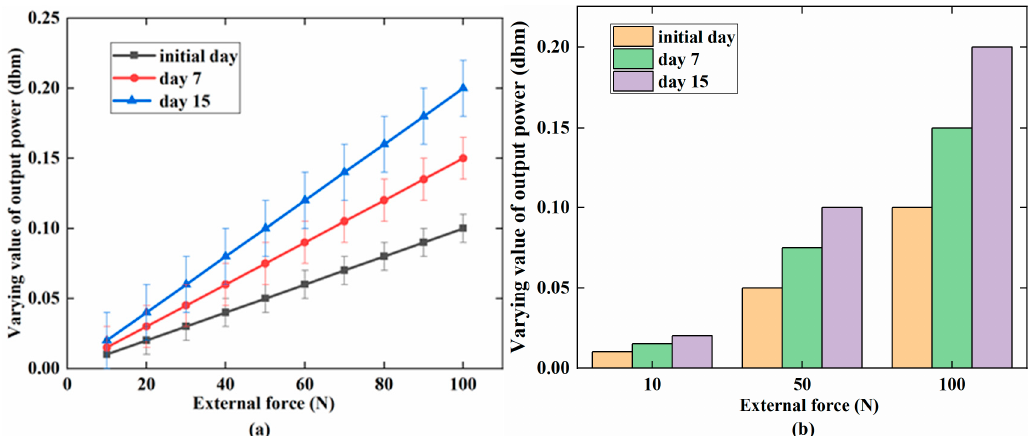
Figure 8. In the alkaline medium (pH = 12): ( a ) the linear increase in the varying value of the output power with an increasing external force (0–100 N) for the three phases; ( b ) the comparison of output power (dbm) for days 0, 7, and 15 at 10, 50, and 100 N.